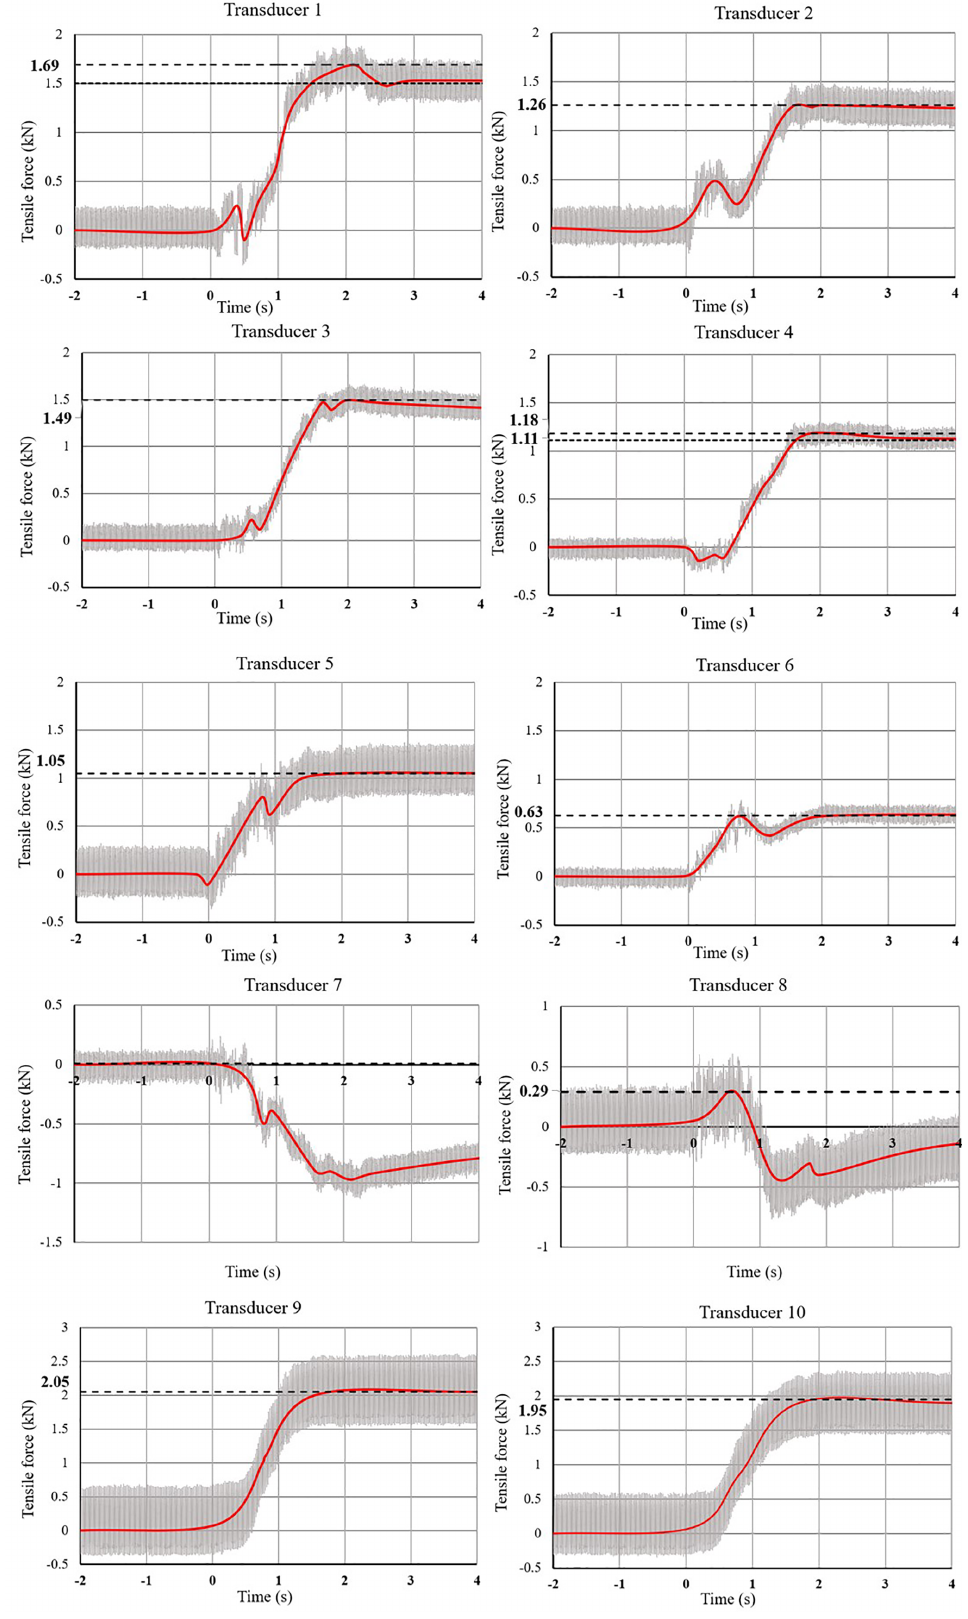
Figure 7. Recorded forces vs. time by the mini tension link transducers between rings in test